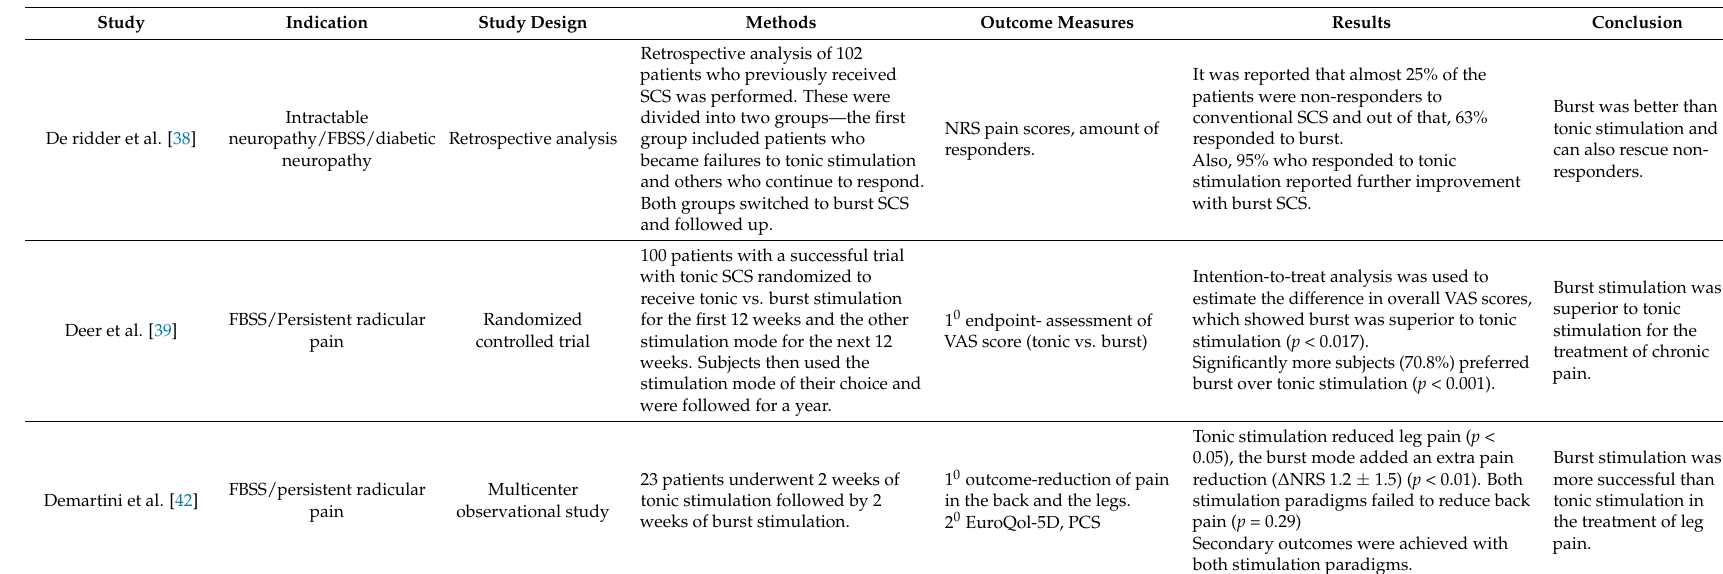
Table 3. Comparative studies between conventional/tonic & burst